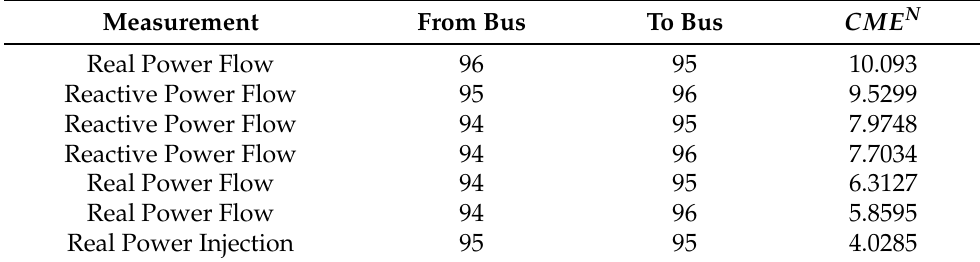
Table 2. Parameter Cyber-attacks Identification [30].